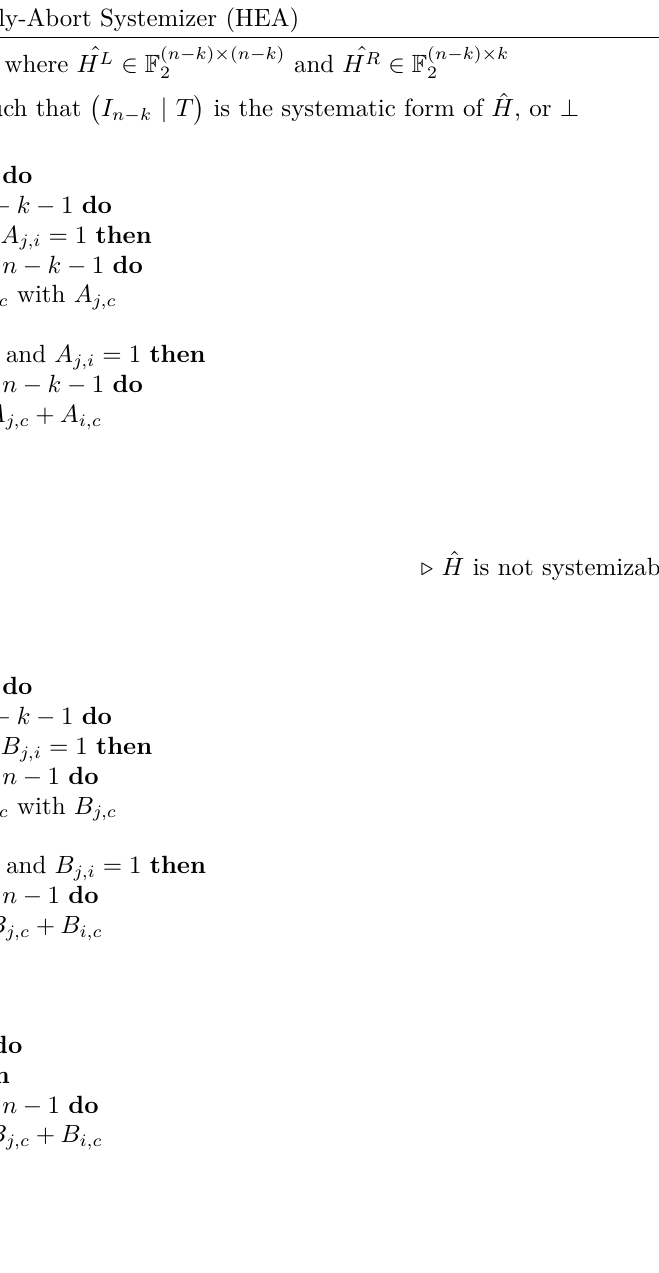
Algorithm 8 Hybrid Early-Abort Systemizer